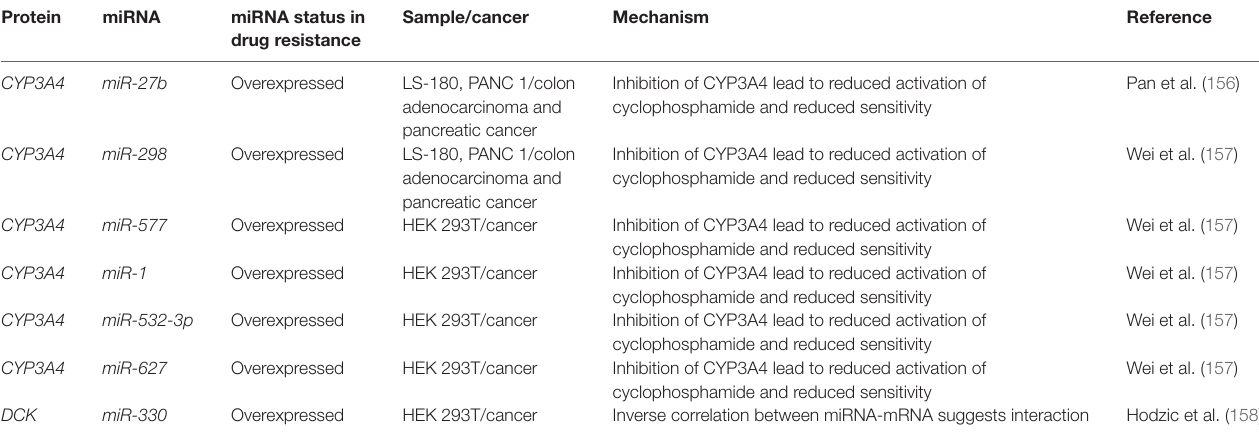
TABLe 4 | miRNA targeting proteins involved in drug metabolism. Protein